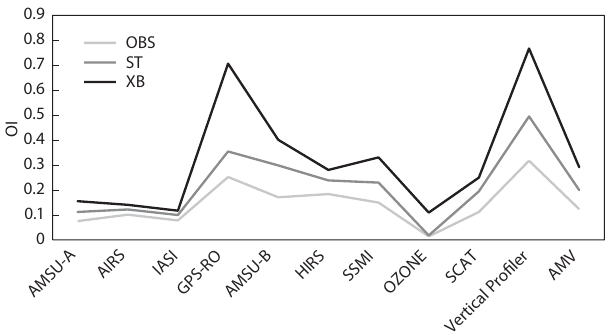
Figure 9. Global average observation influence (OI) for the differ- ent observation types assimilated in the XB (black line), ST (dark grey line), OBS (light grey line) 4DVar analyses. AMSU-A and AMSU-B are microwave radiances, AIRS and IASI and HIRS in- frared radiances, SSMI microwave imager radiance, GPS-RO satel- lite GPS radio occultation, OZONE retrieval, SCAT retrieved wind information from microwave scatterometer, atmospheric motion vector (AMV) from geostationary cloud imagery and vertical pro- filer consists of wind from radiosonde, pilot, aircraft and wind pro- filer